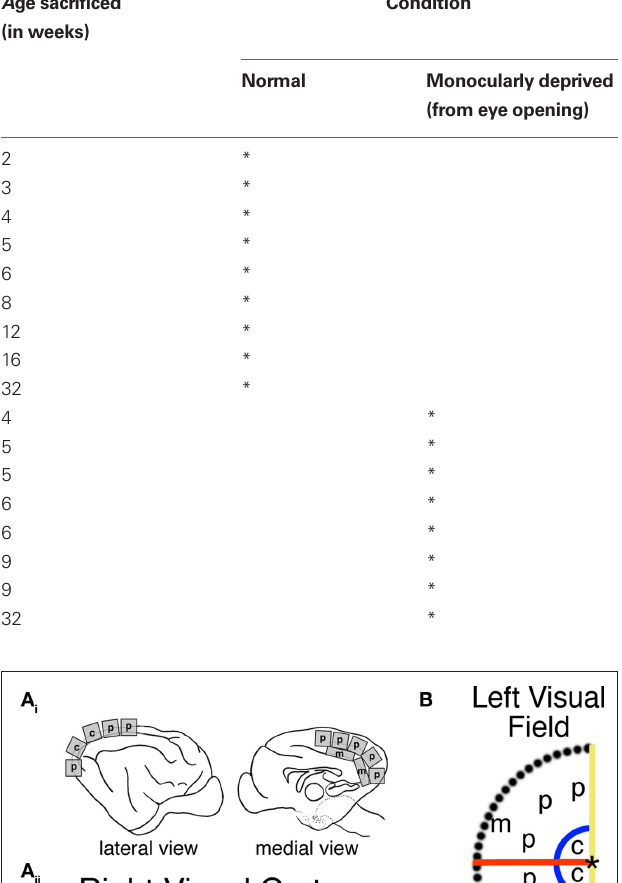
Table 1 | Animal rearing conditions.